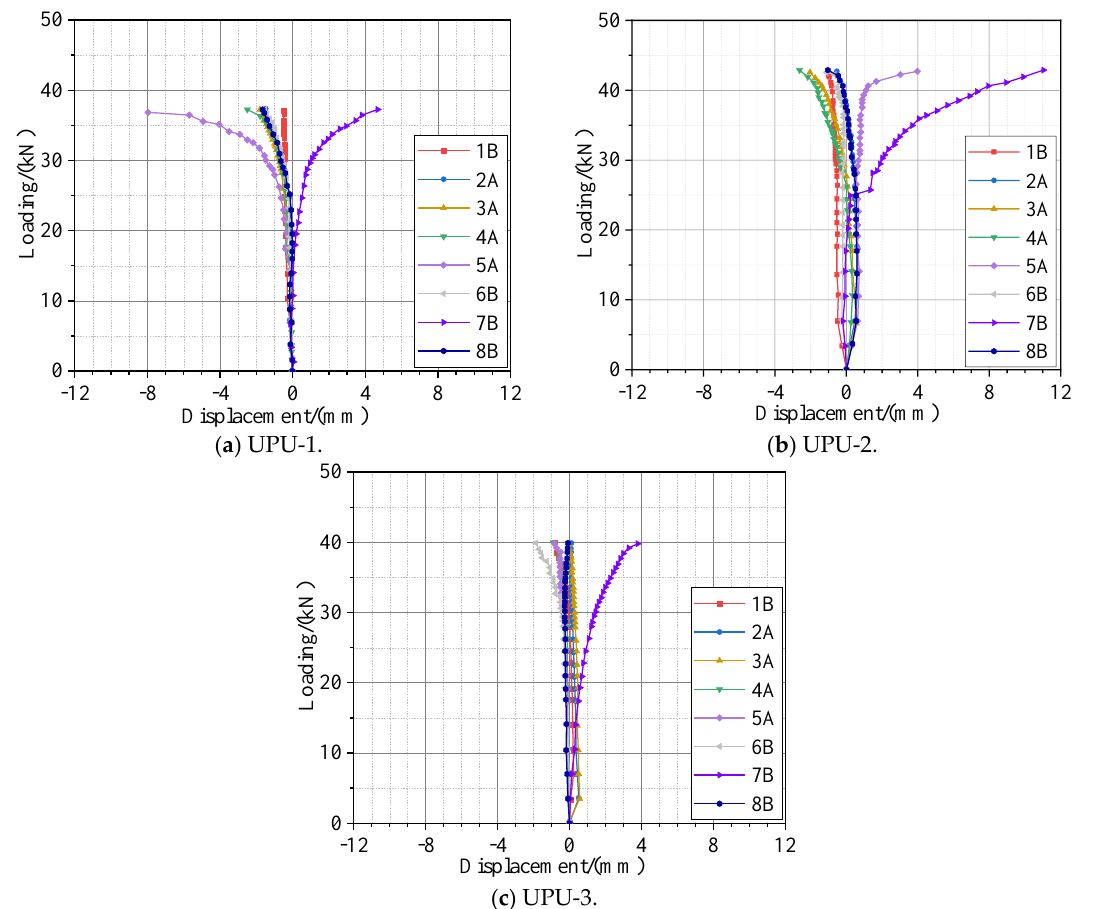
Figure 17. Loading-displacement curves of specimens in group